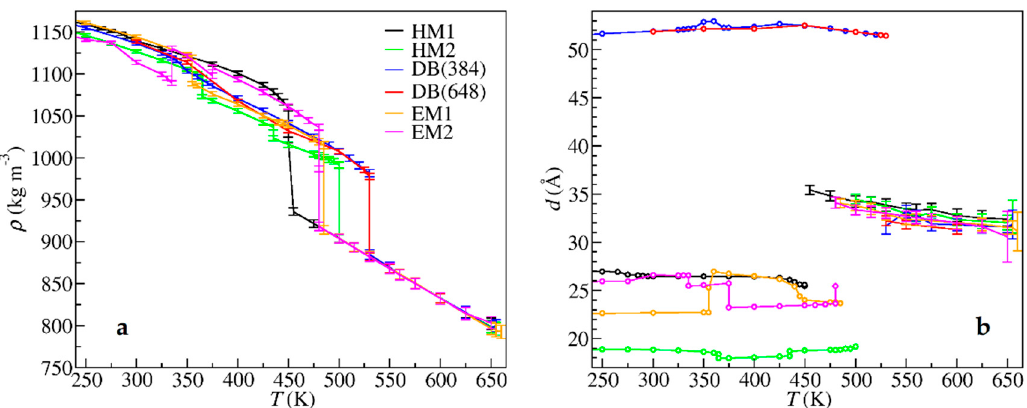
Figure 5. ( a ) System density and ( b ) layer spacing versus temperature. The error bars represent variances, and for the points without error bars, the error bars are smaller than the symbols.